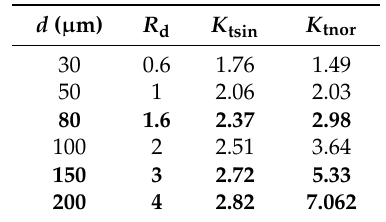
Table 3. The results of K tnor at diverse pit depths for double intersecting pits with λ = 0.8 and θ = 90°. The supplementary results are shown in bold.